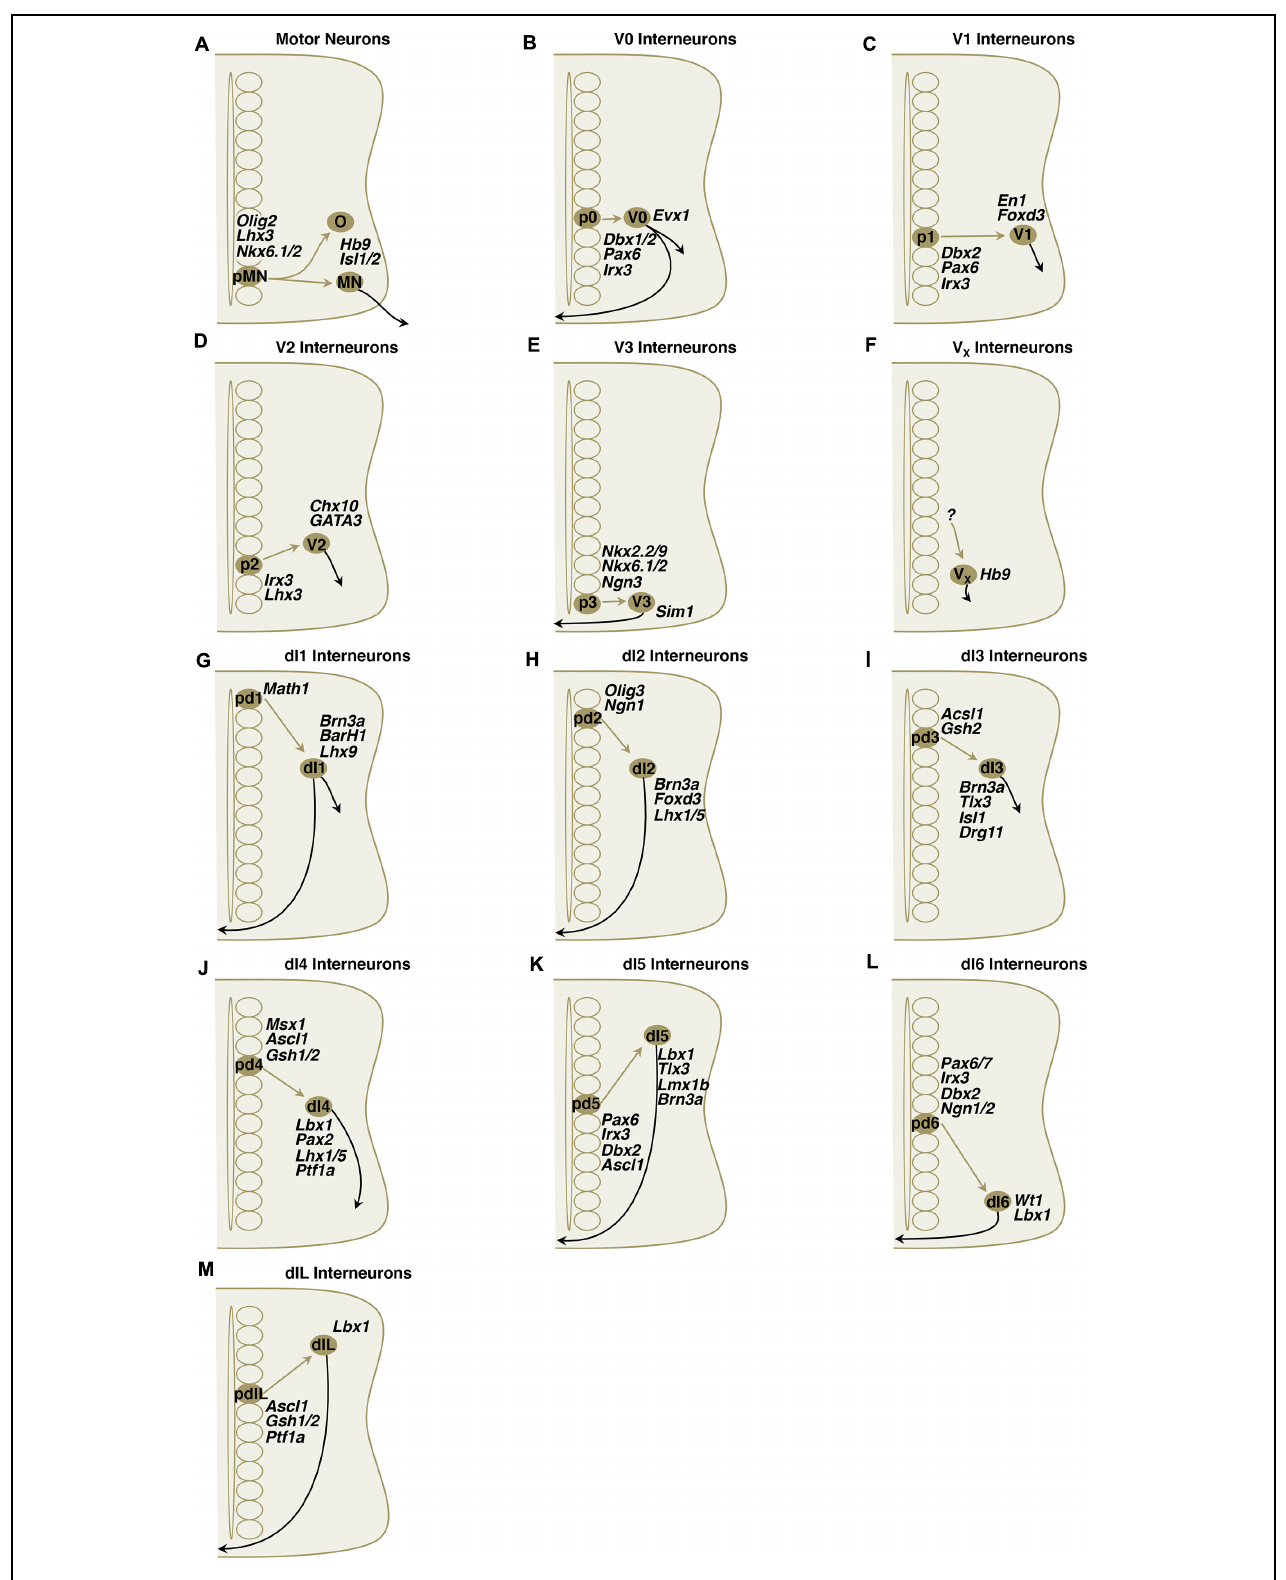
FIGURE 4 | (A–M) Simplified schematic illustrations of development of MNs and ventral/dorsal subclass interneurons with important transcriptional factors.